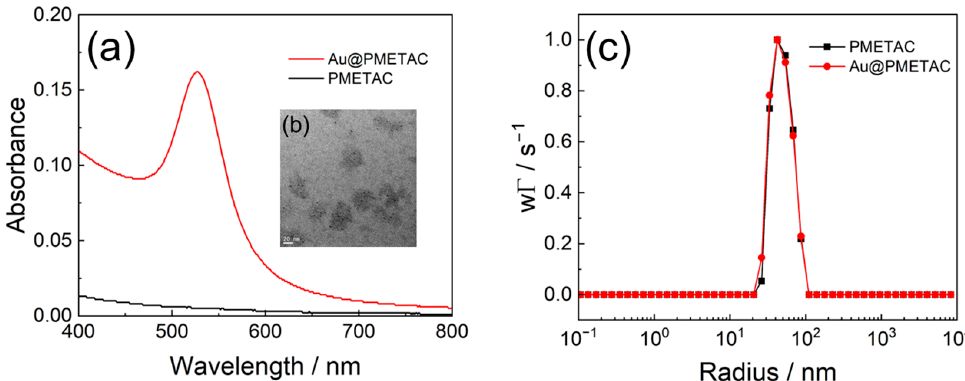
Figure 3. ( a ) UV-Vis spectra of PMETAC and Au@PMETAC nanogels. ( b ) TEM image of Au@PMETAC nanogel. ( c ) Size distribution of PMETAC and Au@PMETAC nanogels. Nanogel syn- Au@PMETAC nanogel. ( c ) Size distribution of PMETAC and Au@PMETAC nanogels. thesis was carried out at pH 8.5, charge mixing ratio 1:1, cross-linker fraction 10% and 0 mM NaCl.